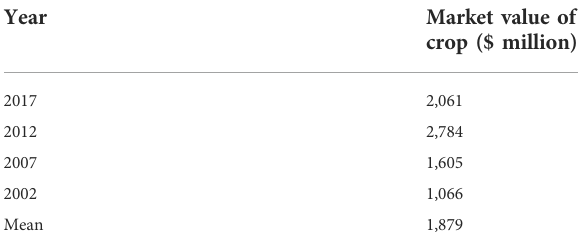
TABLE 7Totalmarket valueof cropproductsin Louisiana (USDA NASS 2020).